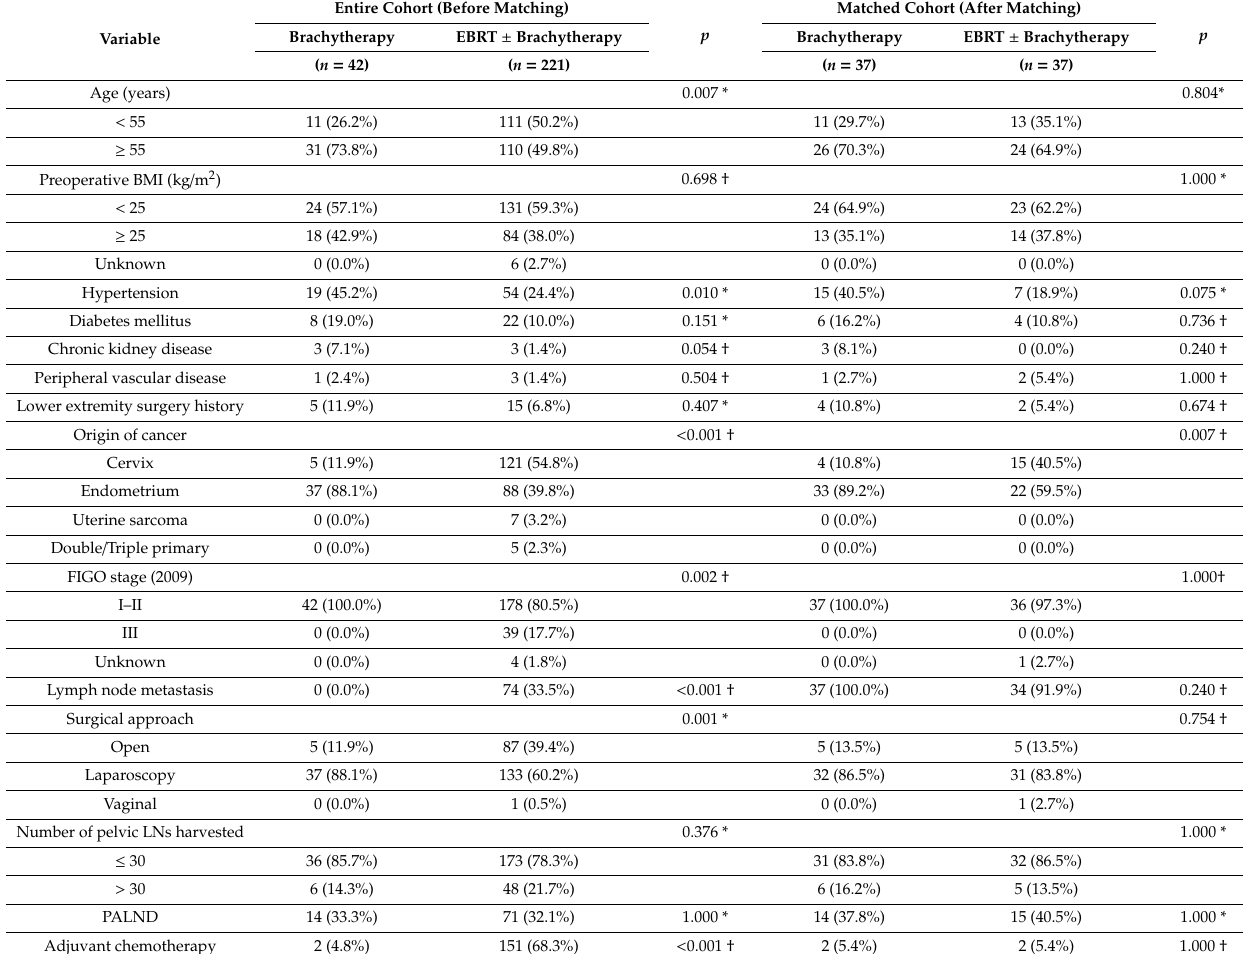
Table 1. Patient characteristics in the entire cohort and matched